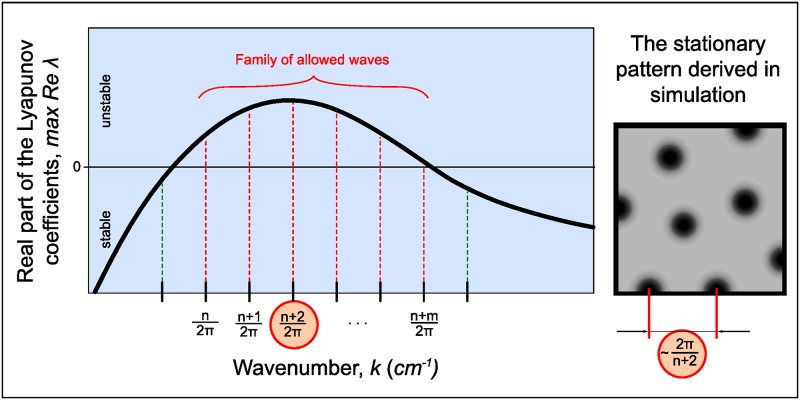
Common shape of the dispersion curve.In the stationary state spatial structures (right pane) have a period which in many cases can be approximately predicted from the dispersion curve (left pane). Self-exited and damping spatial waves are shown with red and dashed lines, respectively.